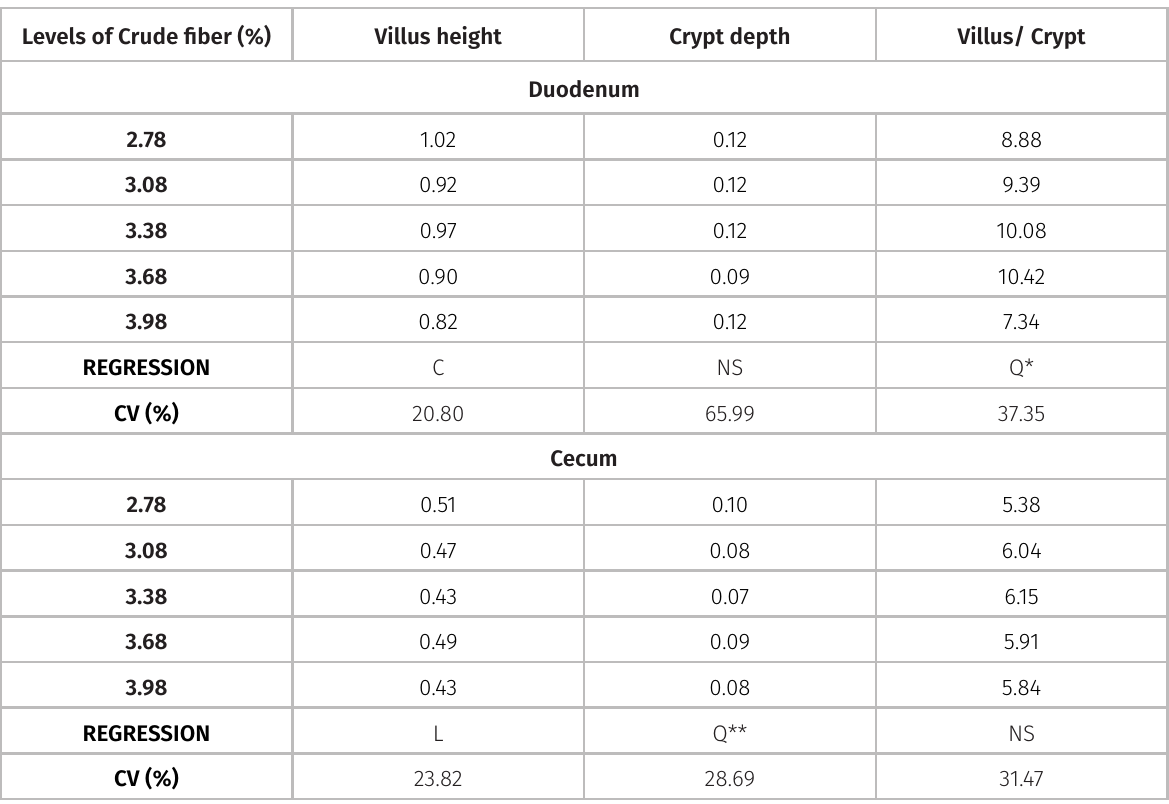
Table VI. Villus height (mm), crypt depth (mm) and villus/crypt ratio of the duodenum, villus height (mm), crypt depth (mm) and villus/crypt ratio of the cecum of Japanese quails fed diets containing different levels of crude